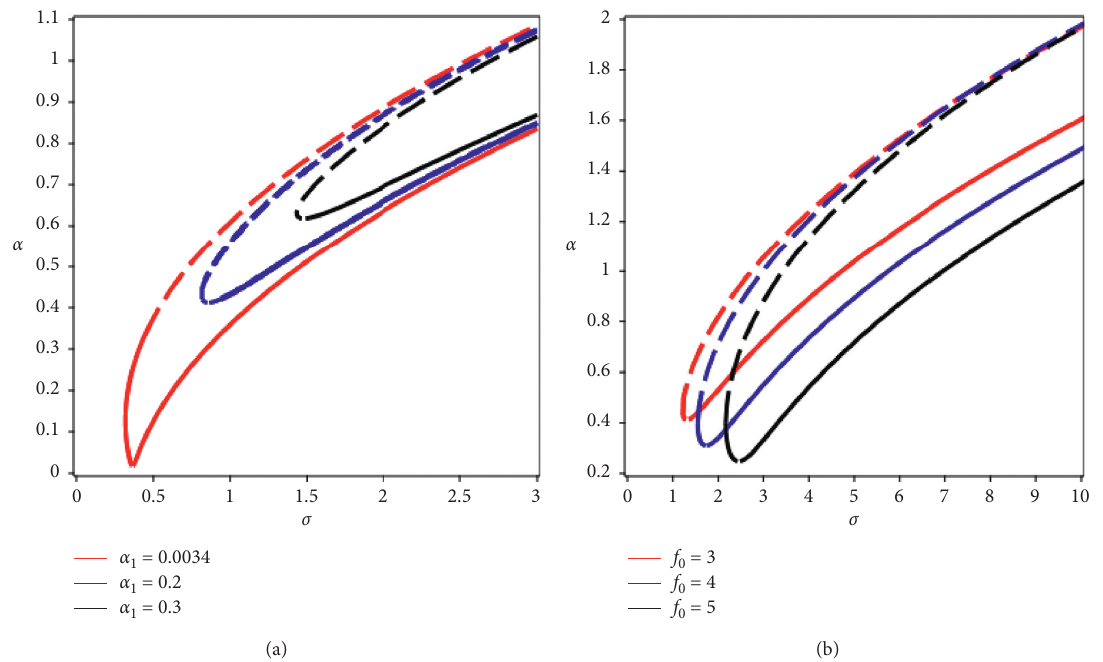
Figure 4: Frequency response for the 1/3-order subharmonic resonance. (a) Ω ≈ 3, α � 2 . 3919. Solid and broken lines are used for the loci of stable and unstable responses, respectively. α 2